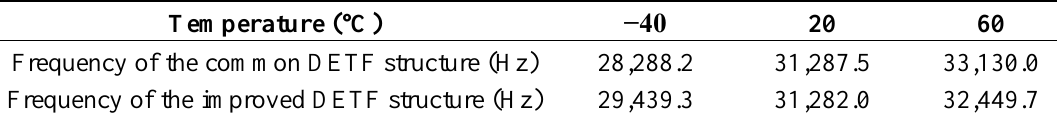
Table 1. Resonant frequency of the DETF at different temperatures (reverse